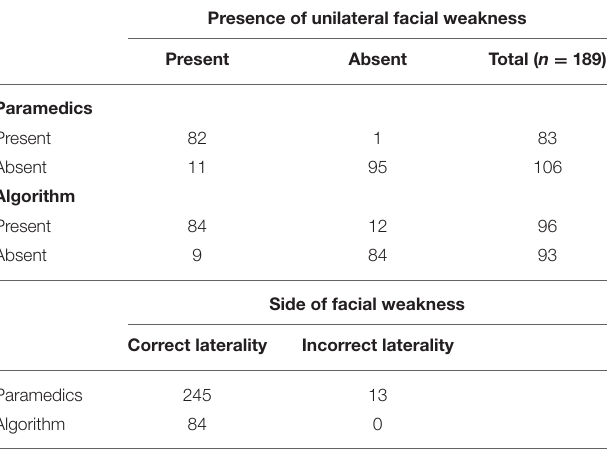
TABLE 2 | Cross tabulation ratings of presence and laterality of unilateral facial weakness by paramedics as a group vs. the machine learning